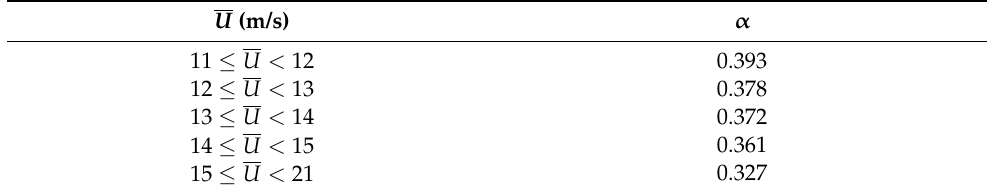
Table 5. Average fitting ground roughness exponents of every record belonging to the same